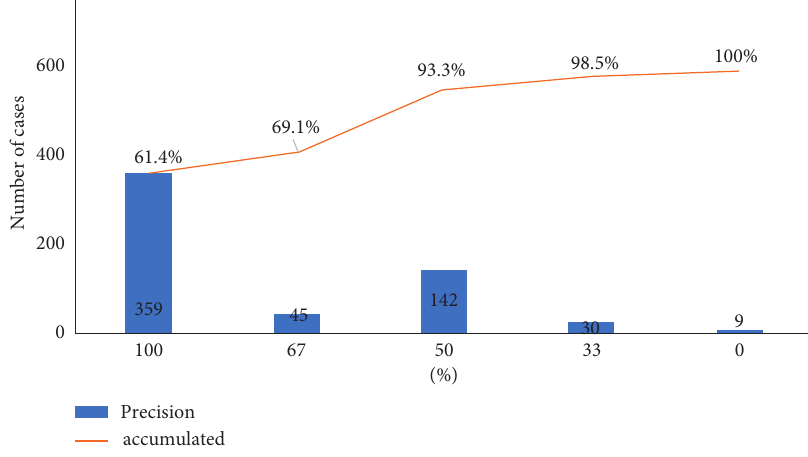
Figure 5: Precision distribution after system revision. Table 8: Adjustment table of interface management